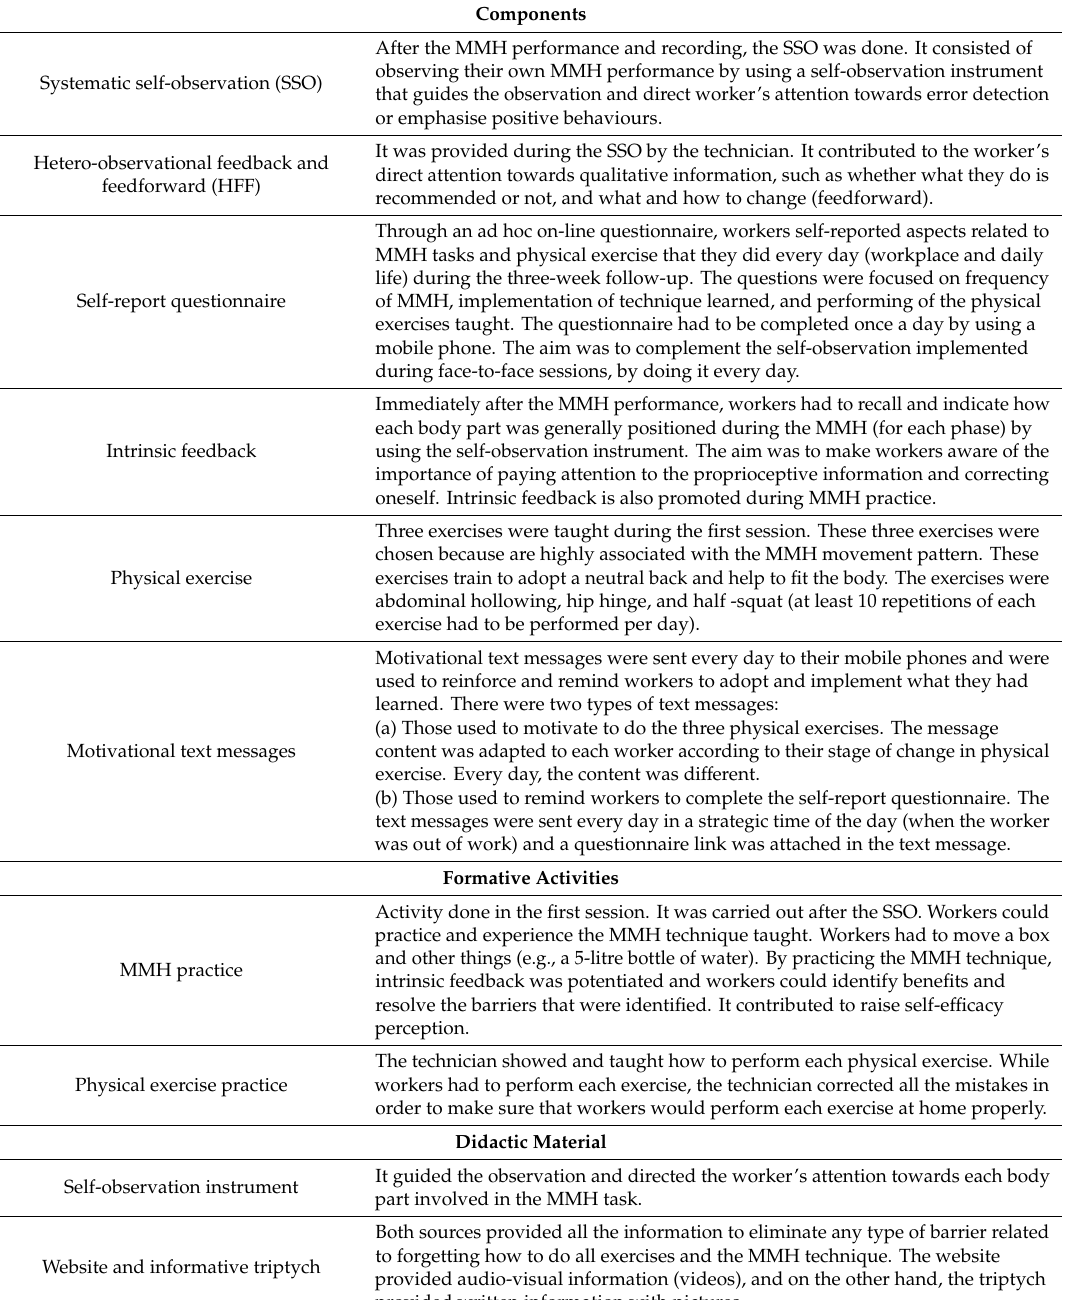
Table A1. Description of the components, formative activities, and didactic material that make up the SsObserWork